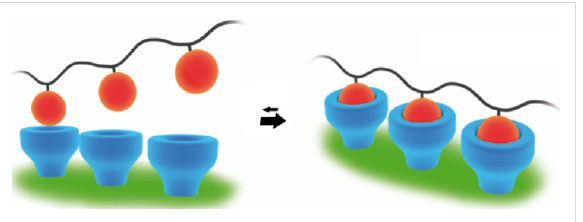
Figure 1: Multivalent interactions shift the equilibrium and enhance the binding strength. Reprinted with permission from [1]. Copyright 2012